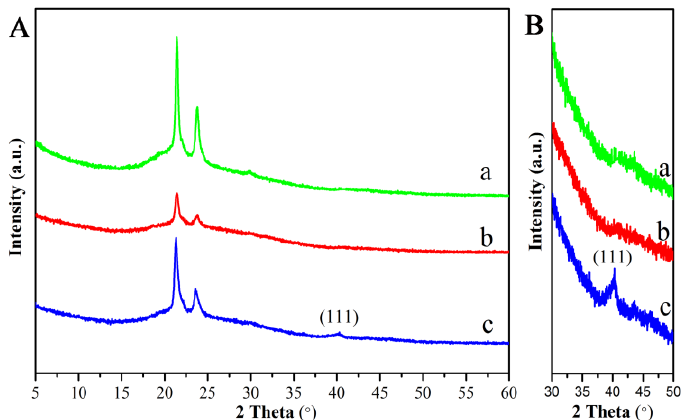
Figure 5. X-ray diffraction spectroscopy ( XRD) pattern ( A ) with zoom-in region ( B ) of PEI/PCL fibers with the weight ratios of 10:90 (a) and 35:65 (b) and PEI/PCL@PdNPs composite (c).